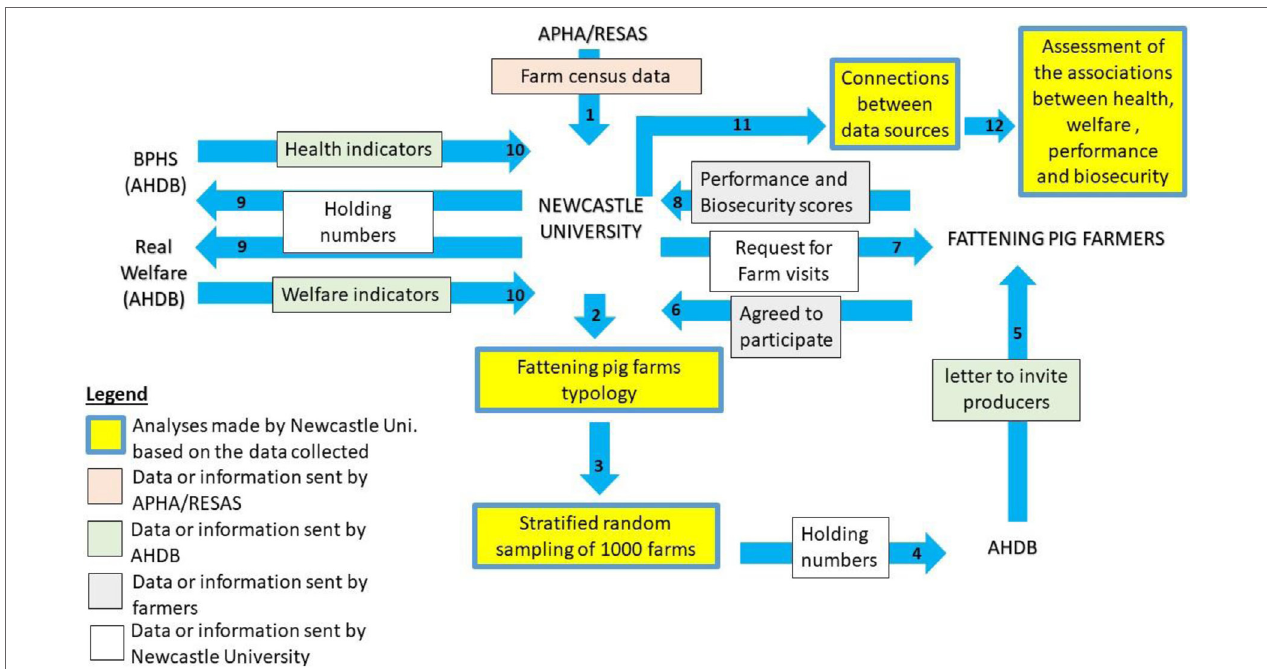
FigUre 1 | Diagram representing the sampling and data collection. Data about biosecurity, health, welfare, and performance were collected on-farm and from the Agricultural and Horticultural Development Board (AHDB) databases [British Pig Health Scheme (BPHS) and Real Welfare schemes]. The sampling was based on farm census data from the Animal and Plant Health Agency (APHA) and the Rural and Environment Science and Analytical Services (RESAS). The numbers on the graph indicate the order of the different steps in the data collection and the data